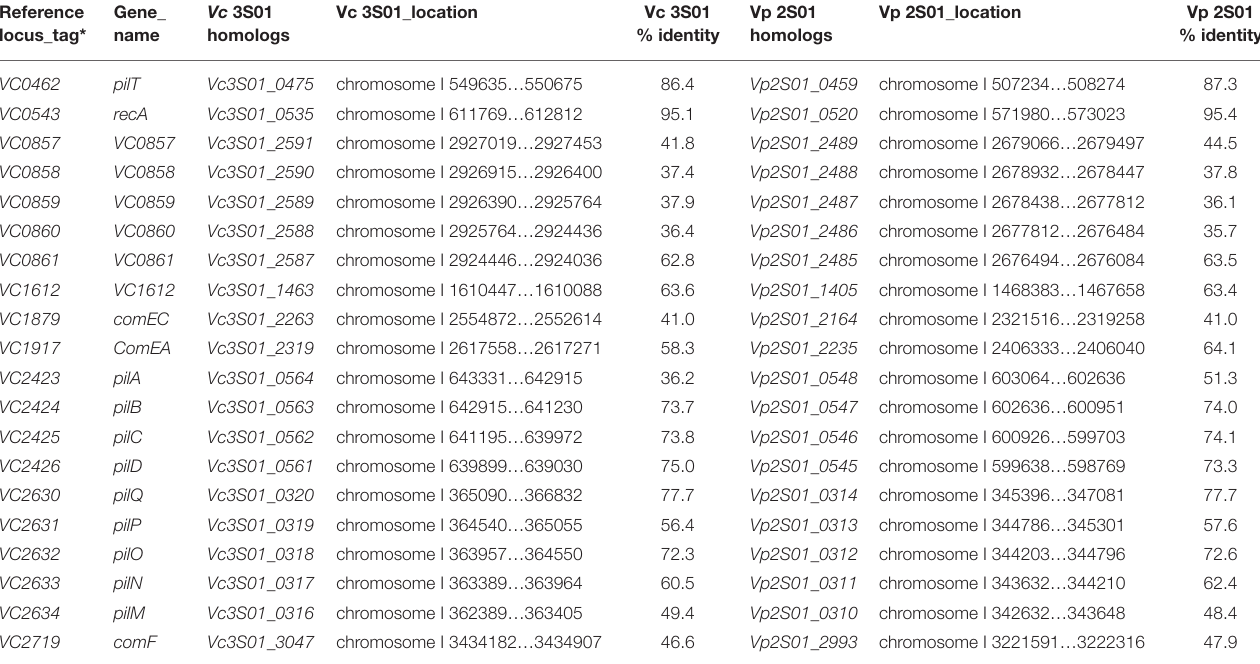
TABLE 1 | Genes required for efficient natural transformation of Vp 2S01 and Vc 3S01. Reference locus_tag*